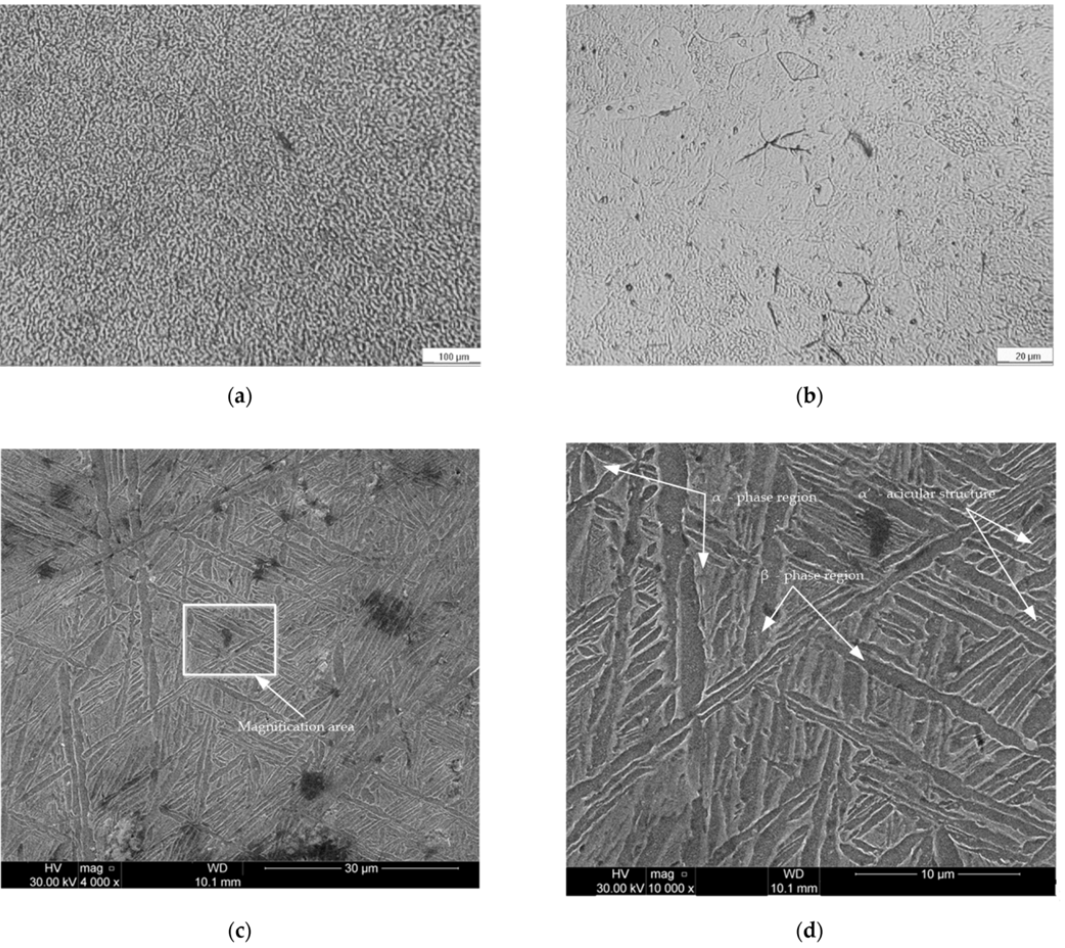
Figure 5. Microscopy image of the Ti64 DMLS samples: ( a ) 100 × ; ( b ) 800 × ; ( c ) 4000 × ; ( d ) 10,000 ×